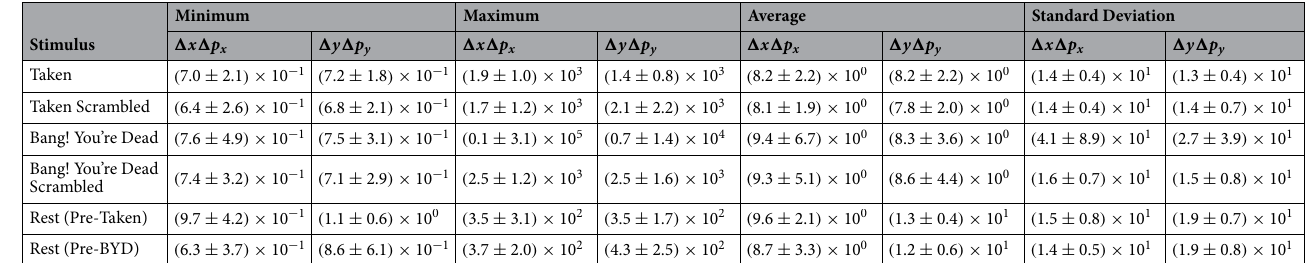
Table 2. Various values extracted from the time courses of the products � x ( t )� p x ( t ) and � y ( t )� p y ( t ) . Considering the minimum value these products reach for each subject, we see a constant value in both x and y cm 2 9.3 ± 4.4 cm 2 of 0.78 ± 0.41 4 ms , an average value of the 4 ms , and a constant standard deviation of cm 2 unit of 4 ms arises from the sampling of 250 Hz. Maximum values differ across stimulation. Values are reported as mean across subjects plus or minus 1 standard